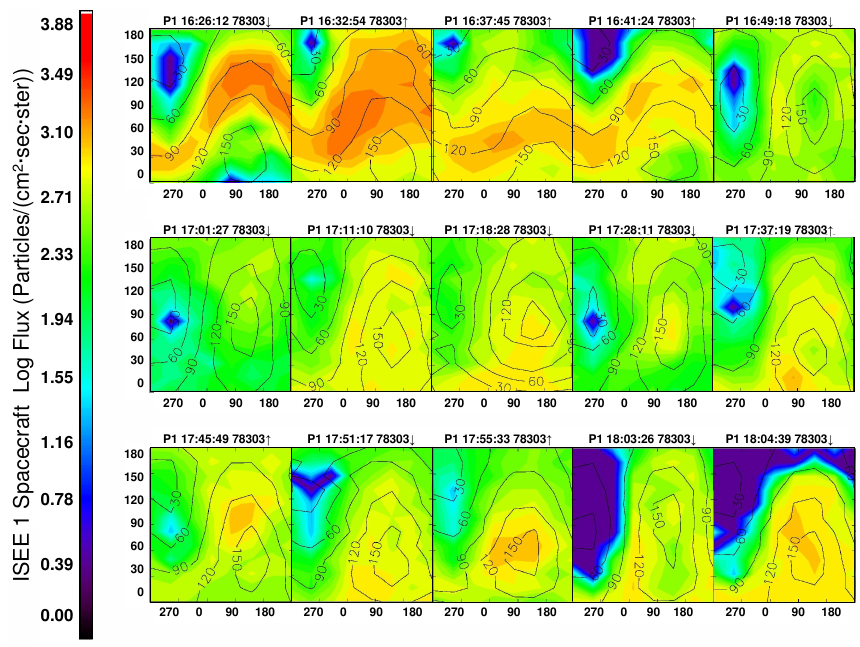
Fig. 4. ISEE-1 MEPE 3-D pitch angle distributions for the time period of 16:26–18:04 UT (Epoch 2 in Fig. 1). This epoch corresponds to when the s/c is traveling through the CDC observing a very turbulent magnetic field, where the particles strongly follow the field lines.